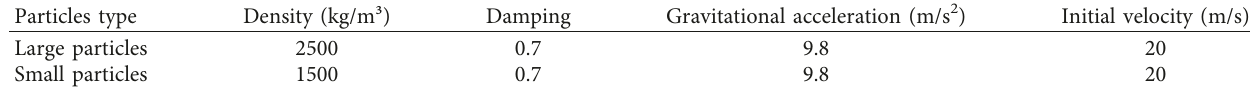
Table 4: Particles property assignment table.